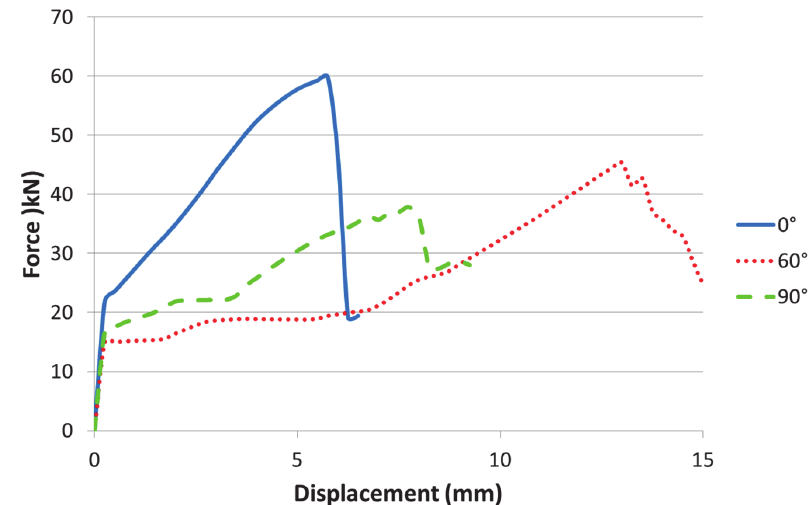
Figure 3: Comparison of the test records of squared timber samples loaded in tension at different angles.